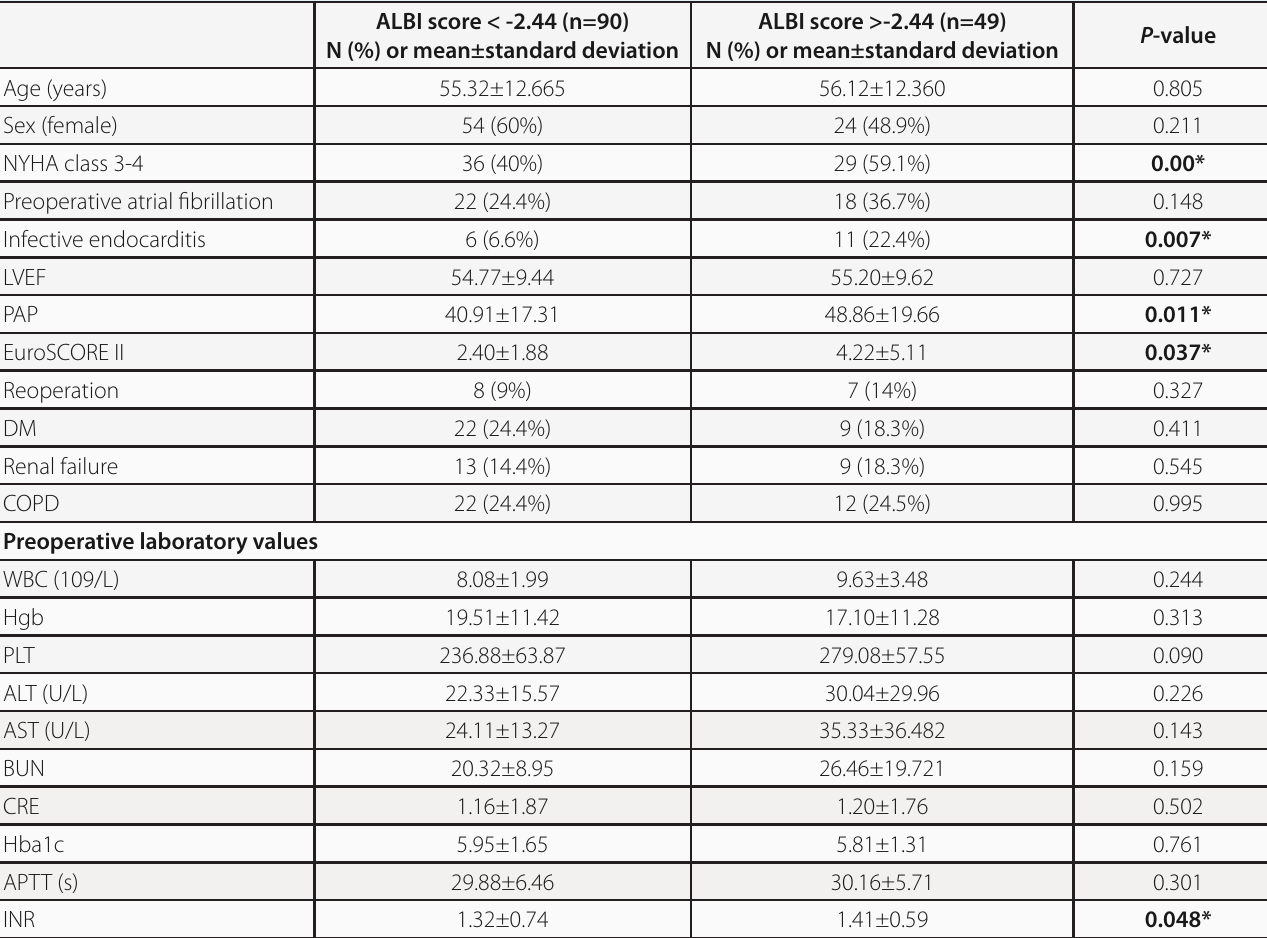
Table 2. Preoperative demographic and clinical characteristics of the patients according to their ALBI scores. ALBI score < -2.44 (n=90)